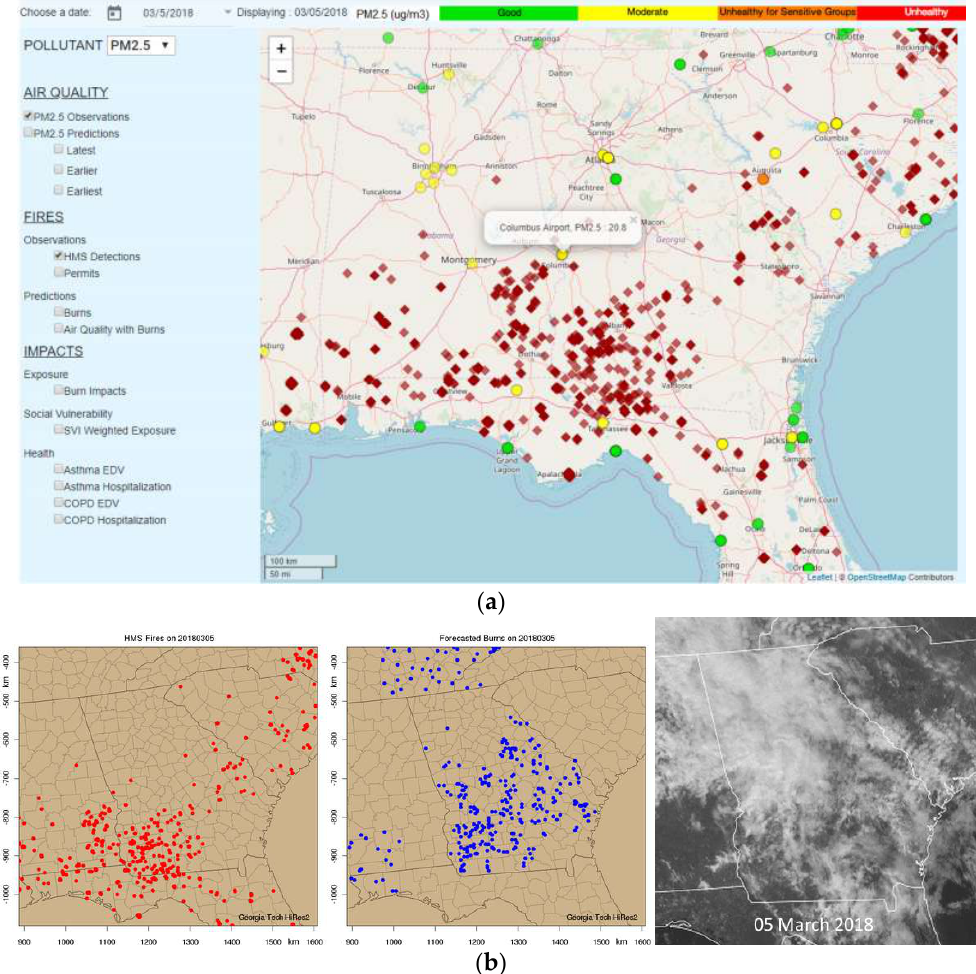
Figure 3. (a) PM 2.5 observations and HMS fire detections in the region surrounding Columbus on 5 March 2018, and ( b ) HMS detections compared with prescribed burns that forecasted by HiRes2, along with the cloud image at 1 p.m. Eastern Standard Time.